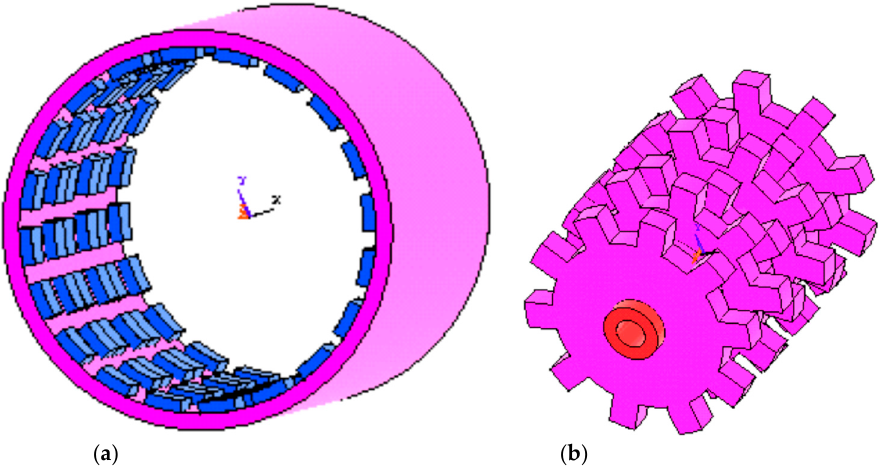
Figure 3. A three-phase transverse flux motor: ( a ) outer rotor with two arrays of PMs per phase on the inner surface of the yoke, and ( b ) three-phase stator cores on a shaft.